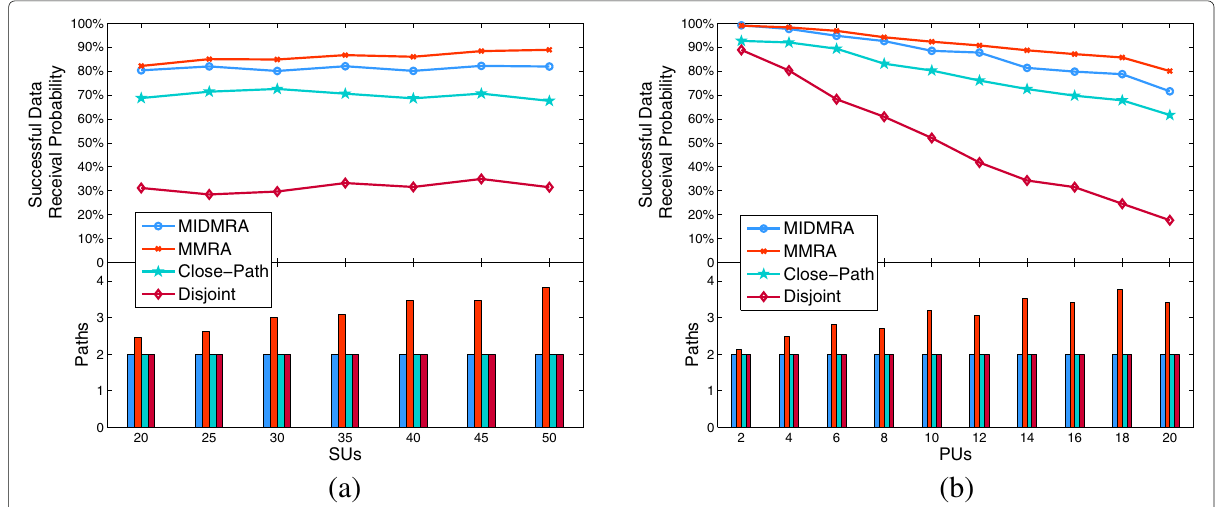
Fig. 7 Multi-path routing mechanisms comparison. a Successful data receival rate with different CR nodes. b Successful data receival rate with different